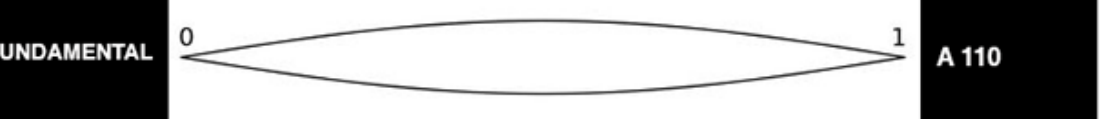
Figure 1. The Fundamental Tone.